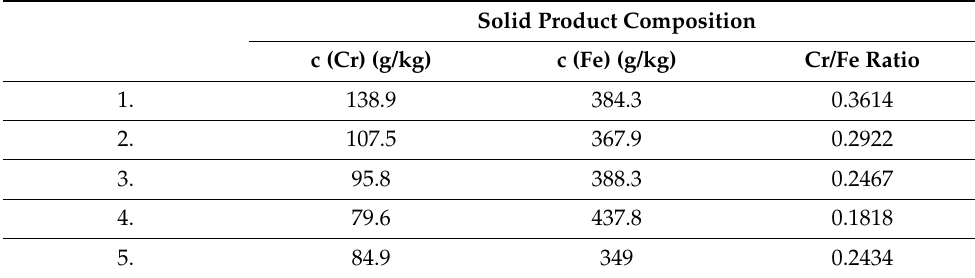
Table 3. Information about the composition of the solid products obtained under different (Table 1) experimental conditions.